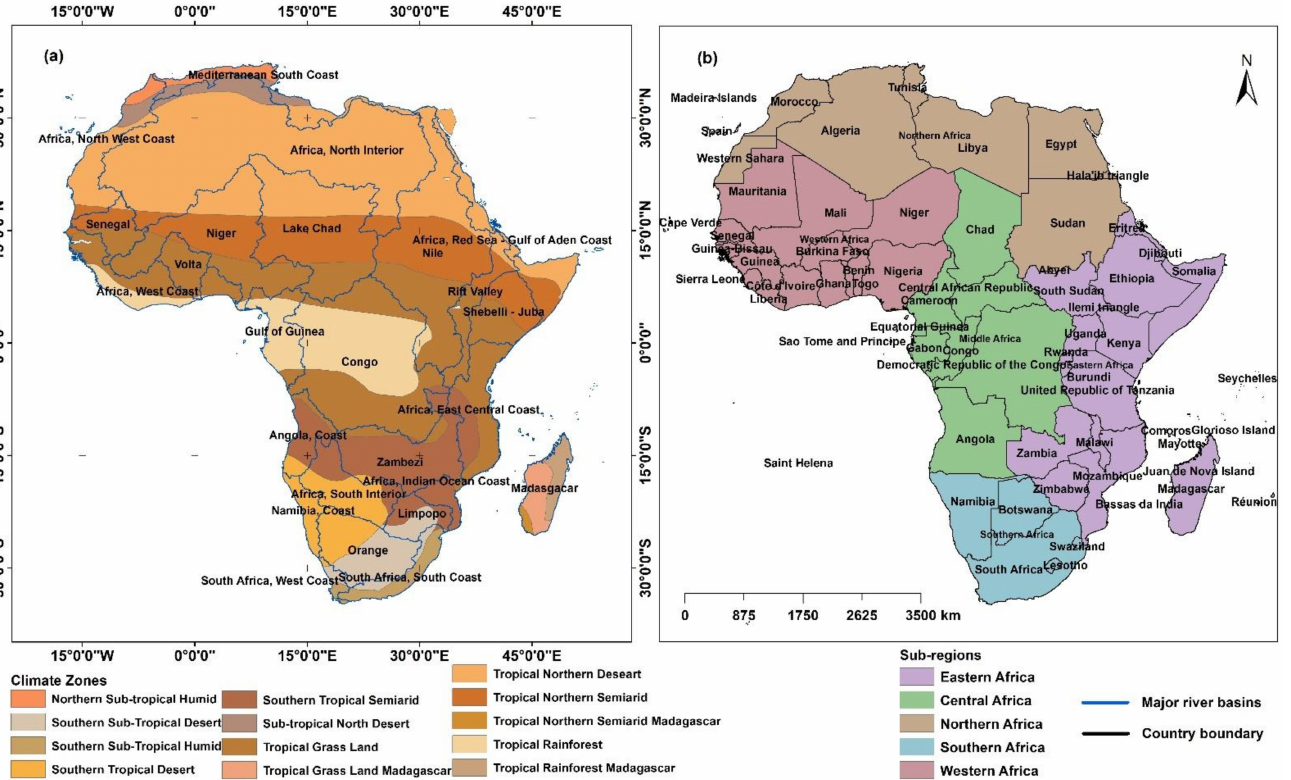
Figure 1. Study area: African continent. ( a ) climate zone and major river basins. ( b ) five regions and